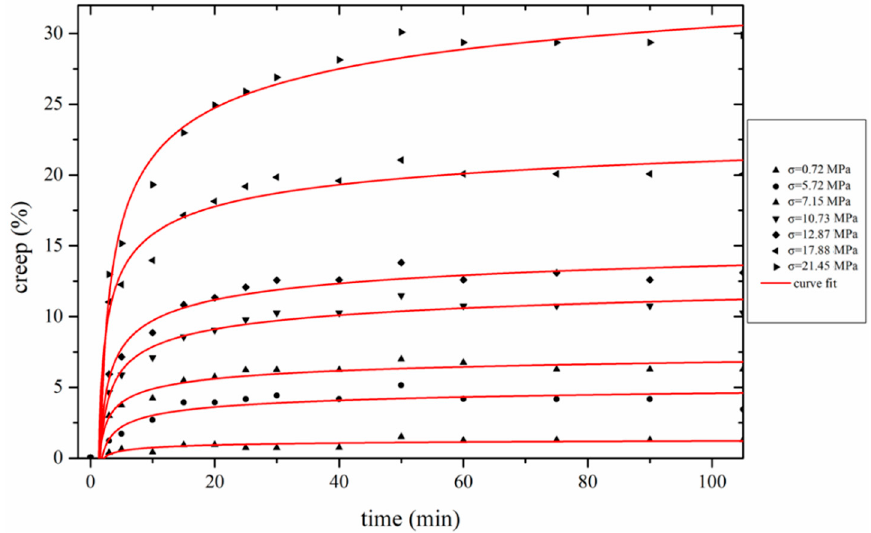
Figure 6. Creep curves for isothermal stabilization of YTD PAN fibers at various applied stress.